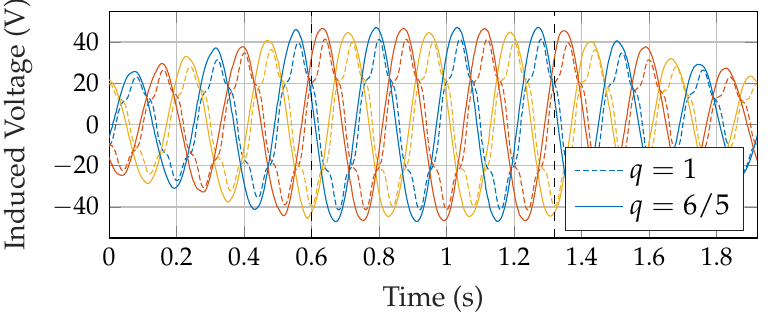
. The stroke length allows for 5